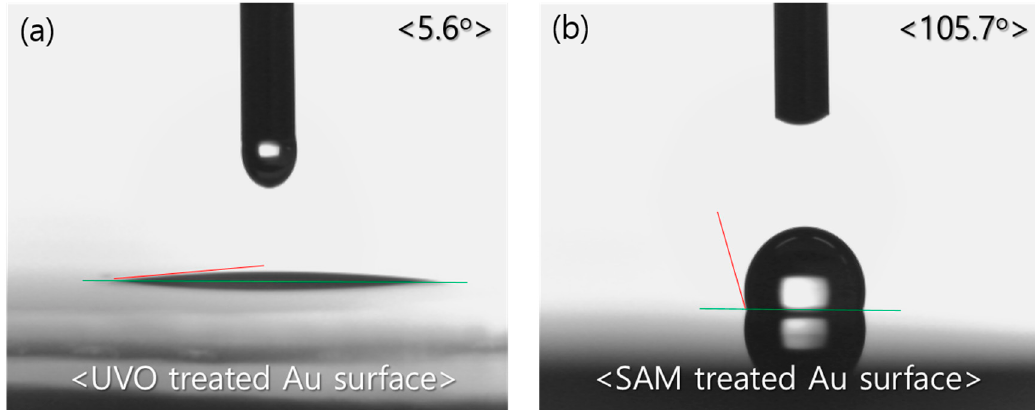
Figure 2. The water contact angle images by dropping deionized (DI) water on the Au-coated patterned template of ( a ) UVO treatment and ( b ) self-assembly monolayer (SAM) treatment.